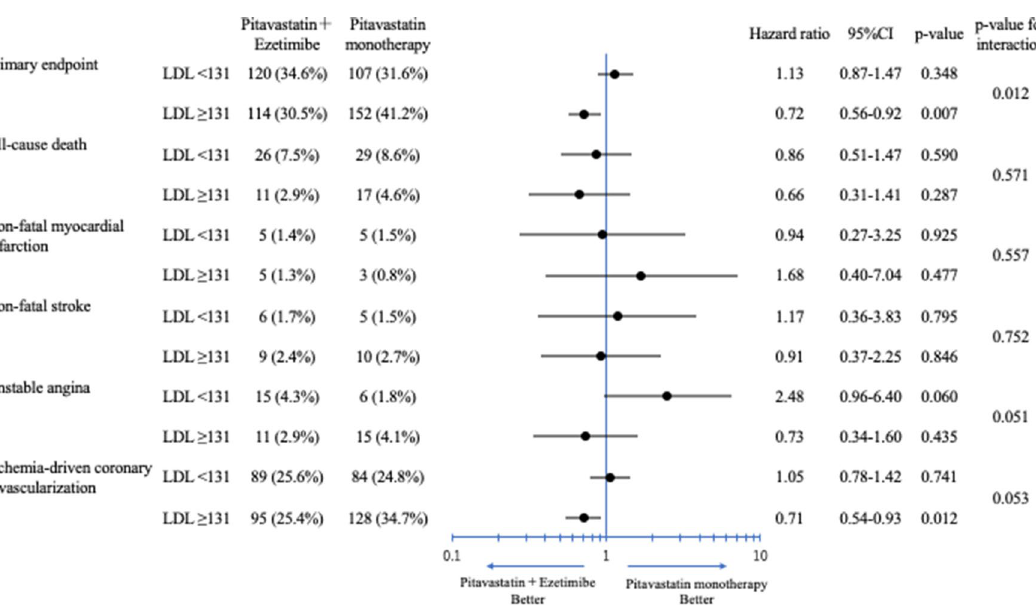
Figure 4. The hazard ratios for the primary endpoint and individual events stratified by median of baseline LDL-C. LDL-C, low-density lipoprotein cholesterol; CI, confidence